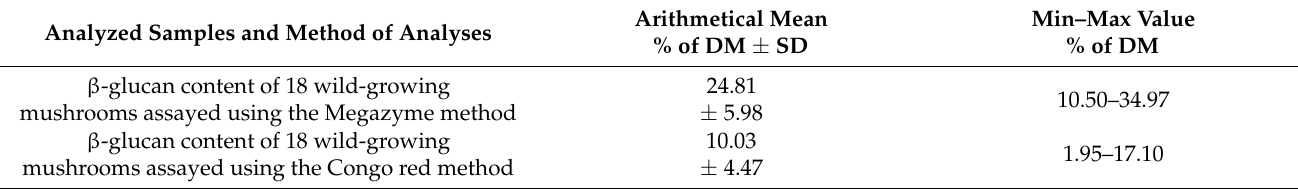
Table 3. β -glucan contents of 18 wild-growing mushrooms determined using the Megazyme and Congo red methods [31].